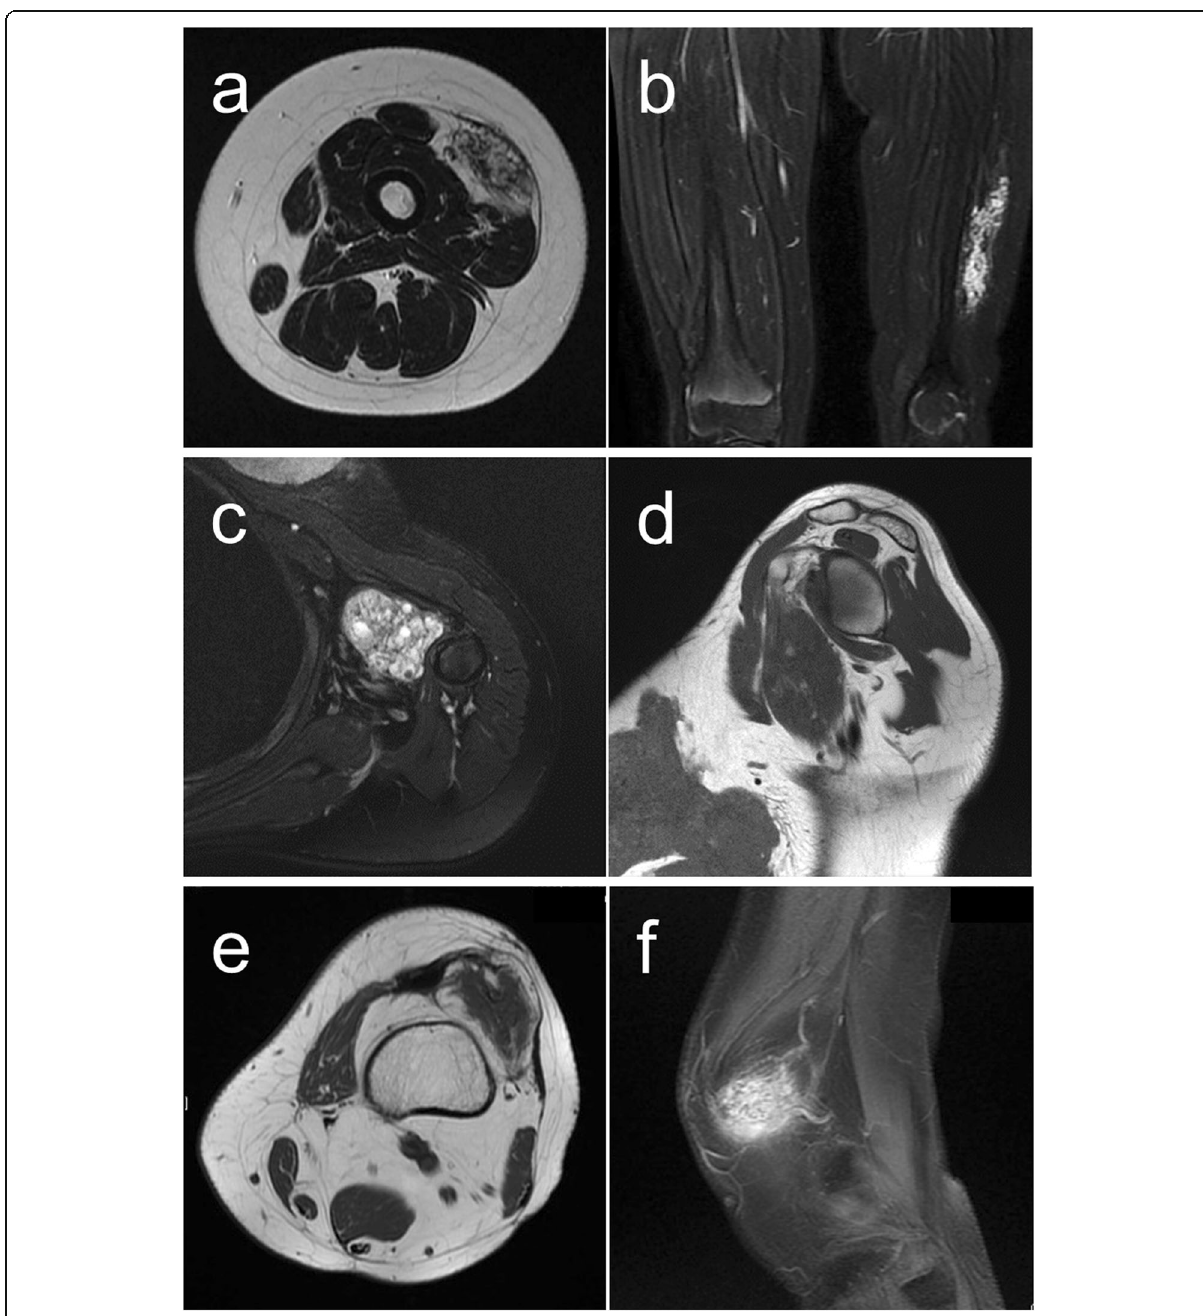
Fig. 1 Magnetic resonance imaging (MRI). Axial T2-weighted MRI ( a ) and coronal fat-saturated enhanced T1-weighted MRI ( b ) of case 1. Axial fat-saturated T2-weighted MRI ( c ) and sagittal T1-weighted MRI ( d ) of case 2. Axial T1-weighted MRI ( e ) and sagittal fat-saturated T2-weighted MRI ( f ) of case